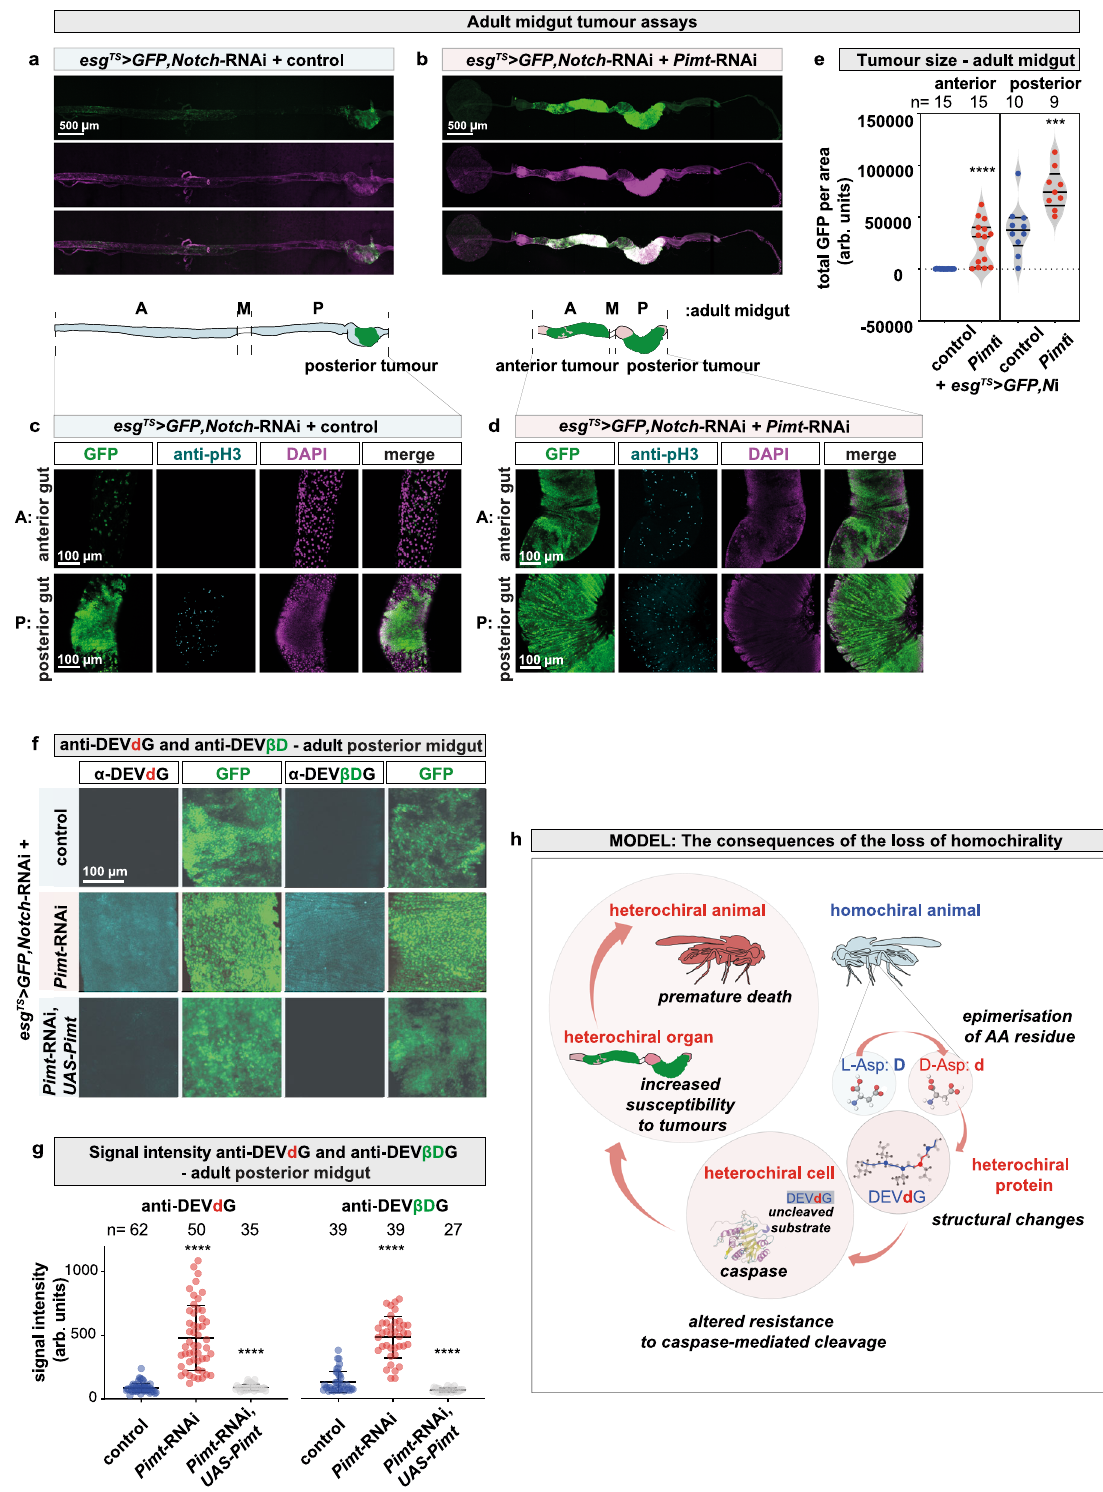
designed for replacing a targeted locus with a 50-bp attP phage recombination site and is positively marked with a removable ( fl oxed) 3XP3-dsRed construct for screening. Pimt null1 mutant gRNAs,